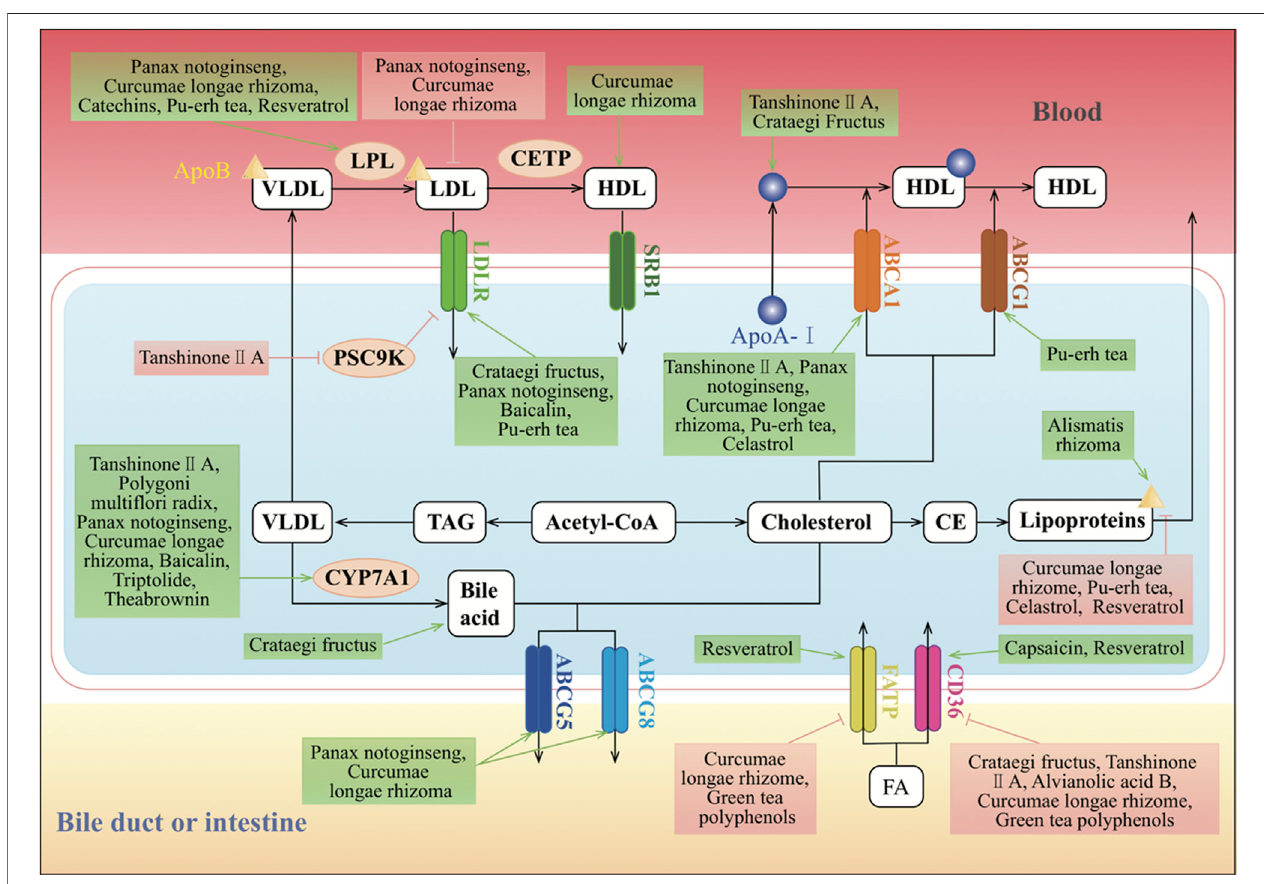
FIGURE2| MolecularmechanismsofTCMsinlipidabsorptionandtransportation.CD36,FATP,andLDLRaretheclassicregulatorsoflipidabsorption.CD36and FATP mediate the absorption of FA, and LDLR mediates the absorption of LDL. SR-BI can mediatethe selective absorption of CE, which plays an important role in HDL metabolism and cholesterol “ reversal. ” Cholesterol is synthesized from acetyl-CoA. Excess cholesterol in hepatic cells is exported to the blood by ABCA1 or the homodimer of ABCG1, or to the intestinal lumen and bile ducts by the ABCG5 and ABCG8 heterodimers. Cholesterol can also be converted to CE by ACAT for storage in lipid droplets or for secretion as lipoproteins. The major forms of lipoproteins are chylomicrons, VLDL, IDL, LDL, and HDL, and they differ in their size, density, composition, and functions. CYP7A1 converts cholesterol into bile acids in the reverse cholesterol transport pathway. In the endogenous pathway, the liver produces VLDL, which interacts with LPL in the circulation to form IDL, with the release of TG and FAs. IDL is rapidly removed by the liver via the interaction of its apolipoprotein E component with LDLR. Furthermore,IDL forms LDL upon removal ofTGby hepatic lipase. CETP induces LDL togenerateHDL,which isan anti-atherogeniclipoprotein or “ good cholesterol, ” as it captures the cholesterol from peripheral tissues or other lipoproteins and transports it back to the liver by the third pathway, which is termed reverse cholesterol transport. ↑ / ⊥ depicts the positive or negative effect of TCMs in the cellular process, respectively.